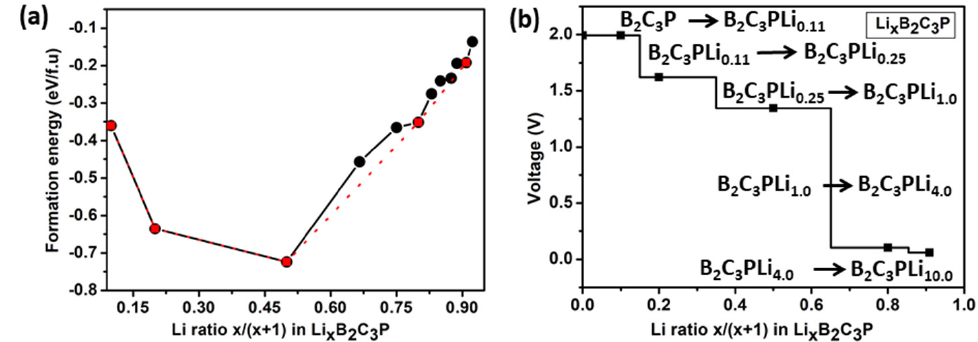
Figure 4. ( a ) Formation energies of B 2 C 3 PLi x related to 2D B 2 C 3 P and bulk Li metal. Data points on the convex hull (red squares) are the stable adsorptions against decomposition. ( b ) Electrode potential of Li-intercalated B 2 C 3 P.